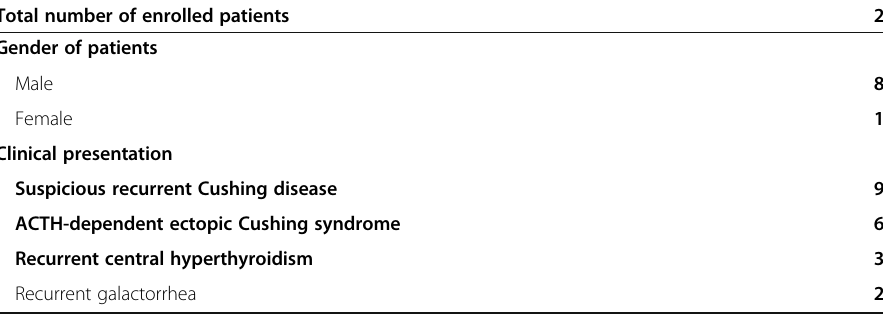
Table 1 Patients ’ demographic and clinical characteristic Total number of enrolled patients Gender of